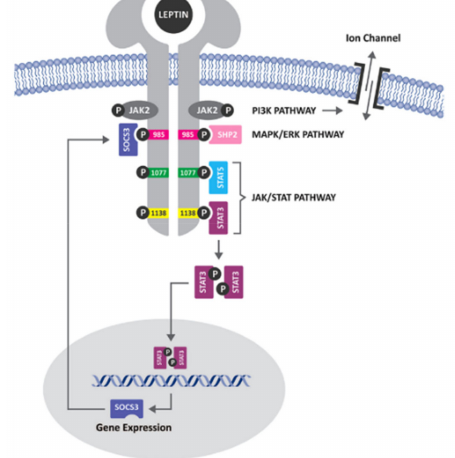
Figure 1. Leptin signalling pathway